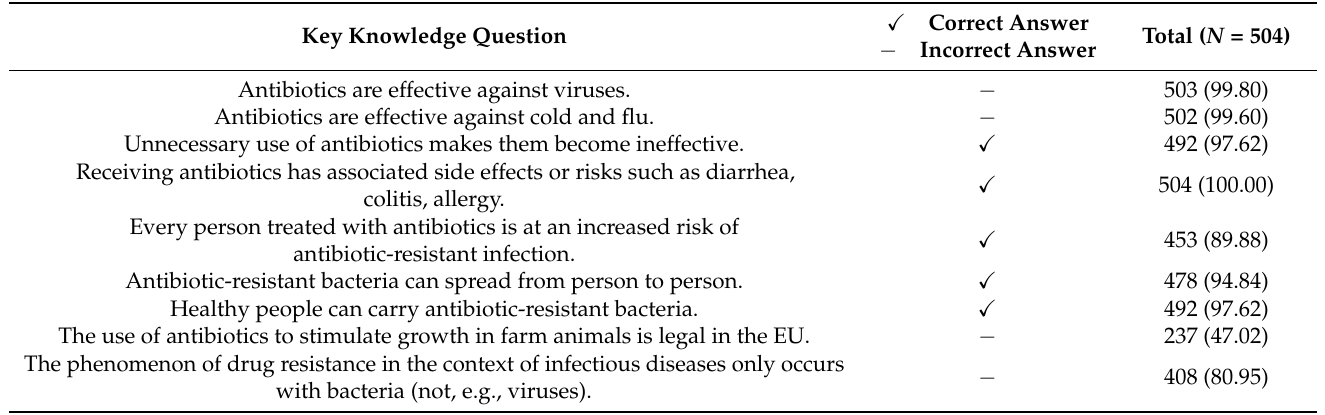
Table 2. Respondents who answered each antibiotic knowledge question correctly.